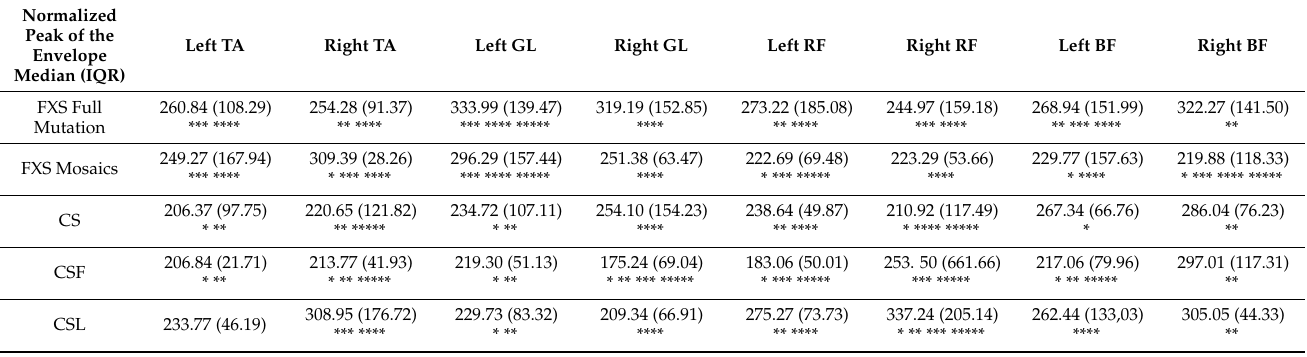
Table 3. Comparison of the value of the peak of the envelope [% of mean value] and position of the peak of the envelope [% of gait cycle], in terms of median and inter quartile range (IQR), for FXS Full Mutation, FXS Mosaics, CS, CSF and CSL. Statistically significant differences ( p -value of the Wilcoxon rank-sum test >0.05) are reported with * with respect to the FXS Full Mutation, ** with respect to the FXS Mosaics, *** with respect to the CS, **** with respect to CSF, ***** with respect to